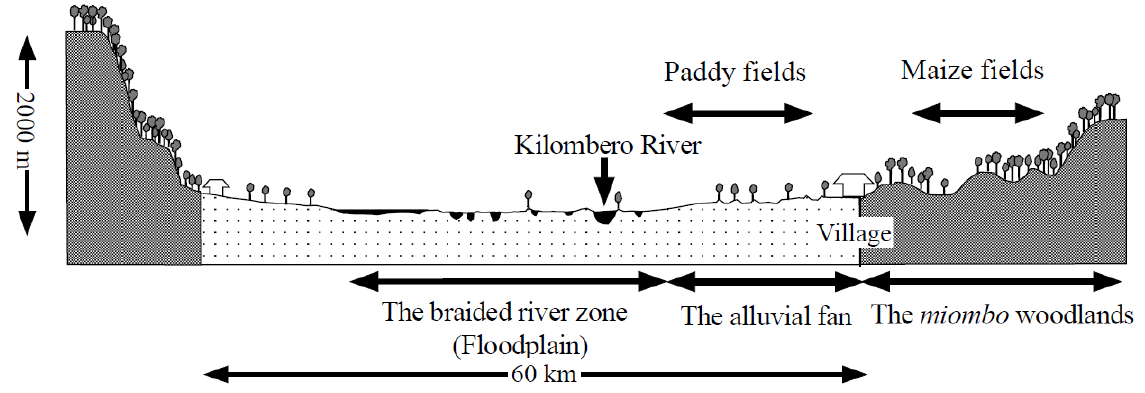
Table 1. Attributes of the Kilombero river catchment – source [39].